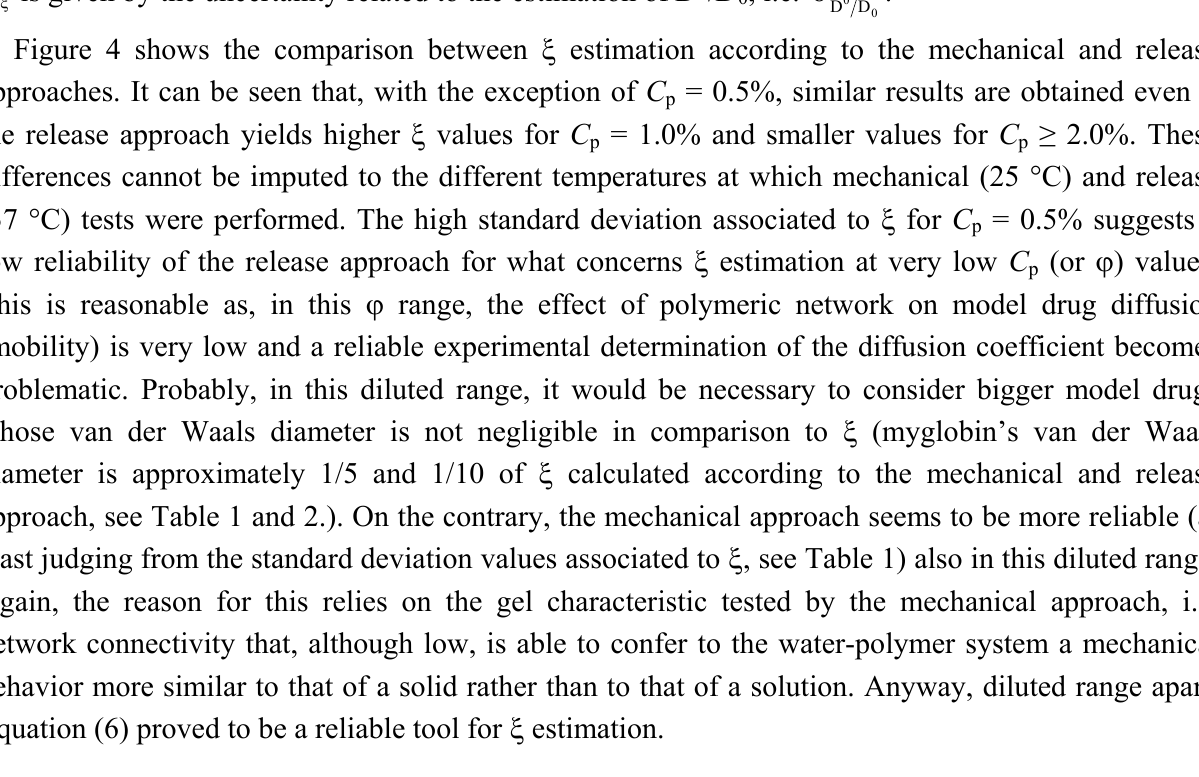
Figure 4. Comparison between the values of the polymeric network average mesh size ( ξ ) calculated according to the mechanical and release approaches. C